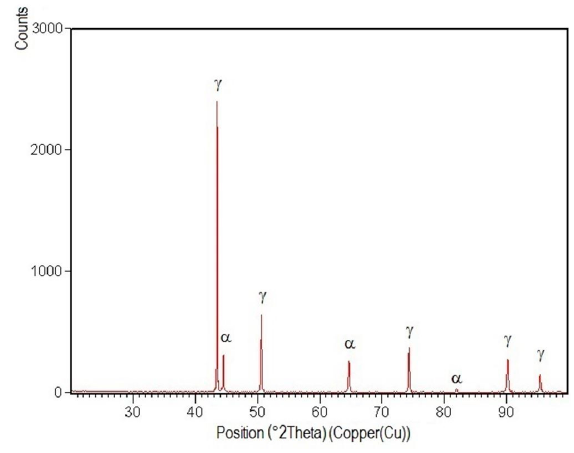
l = 15 kJ/cm. Materials 2016 , 9 , 606 13 of 15